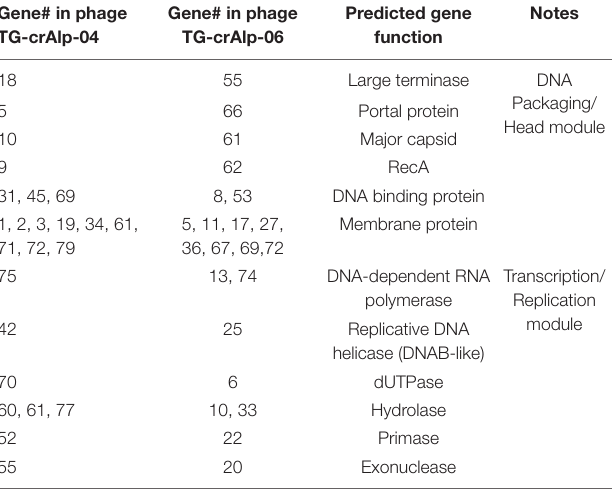
TABLE 2 | List of genes with similar function in both phage